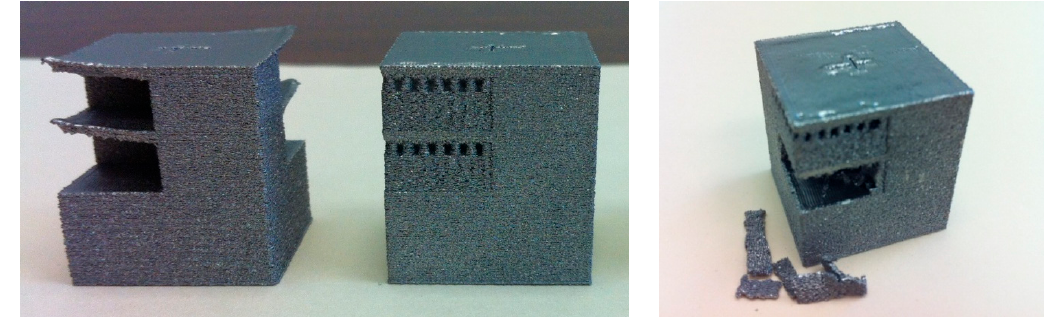
Figure 1. An example of overhang warping and mitigation using conventional support.